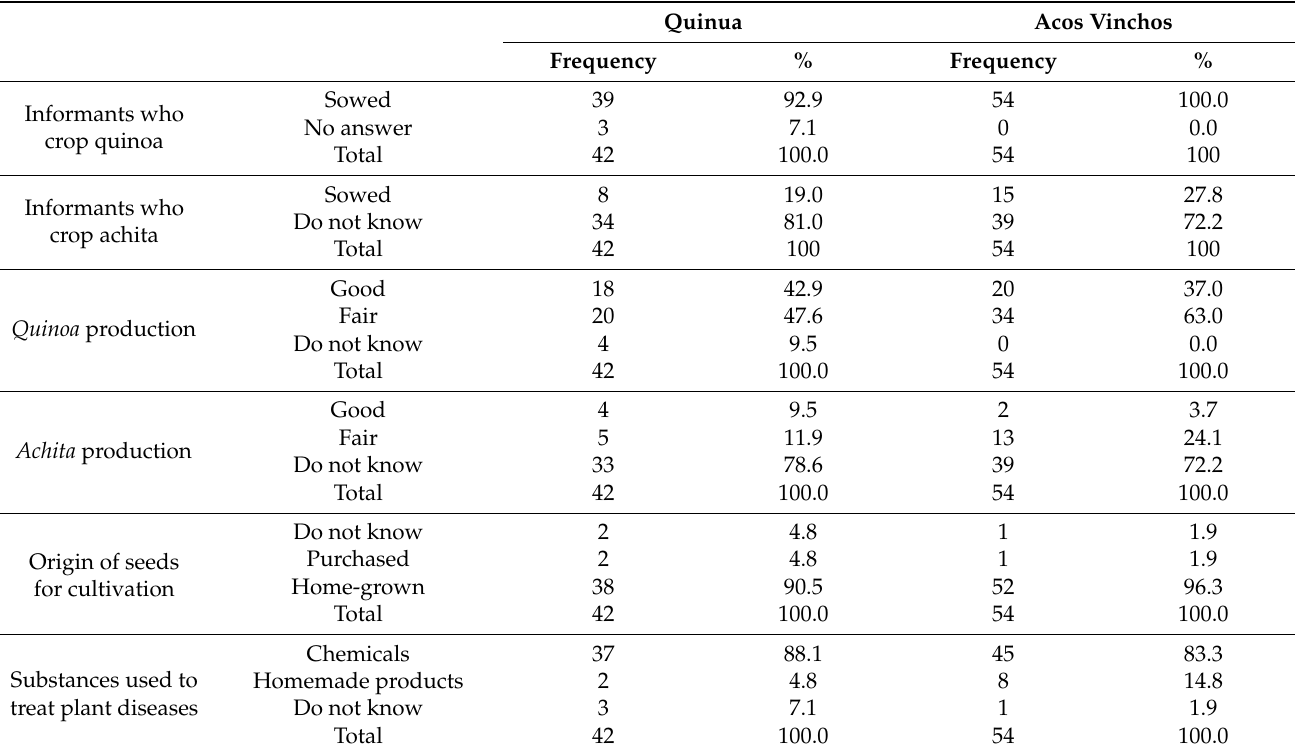
Table 4. Crop management of ancestral Andean grains in the districts of Quinua and Acos